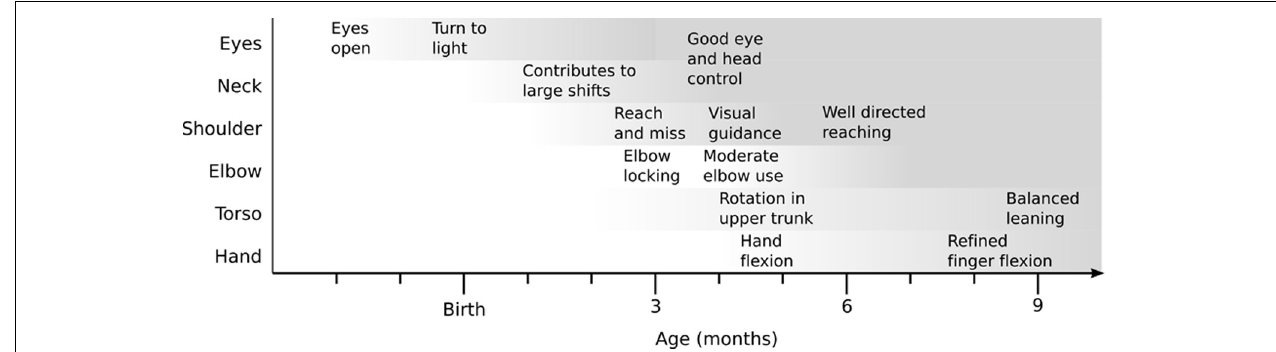
FIGURE 1 | A conceptual diagram of the increase in motor control competence in infancy, highlighting behaviors identified in the infant literature. Darker shading indicates greater competency. This figure is abstracted from the detailed timeline compiled in Law et al.